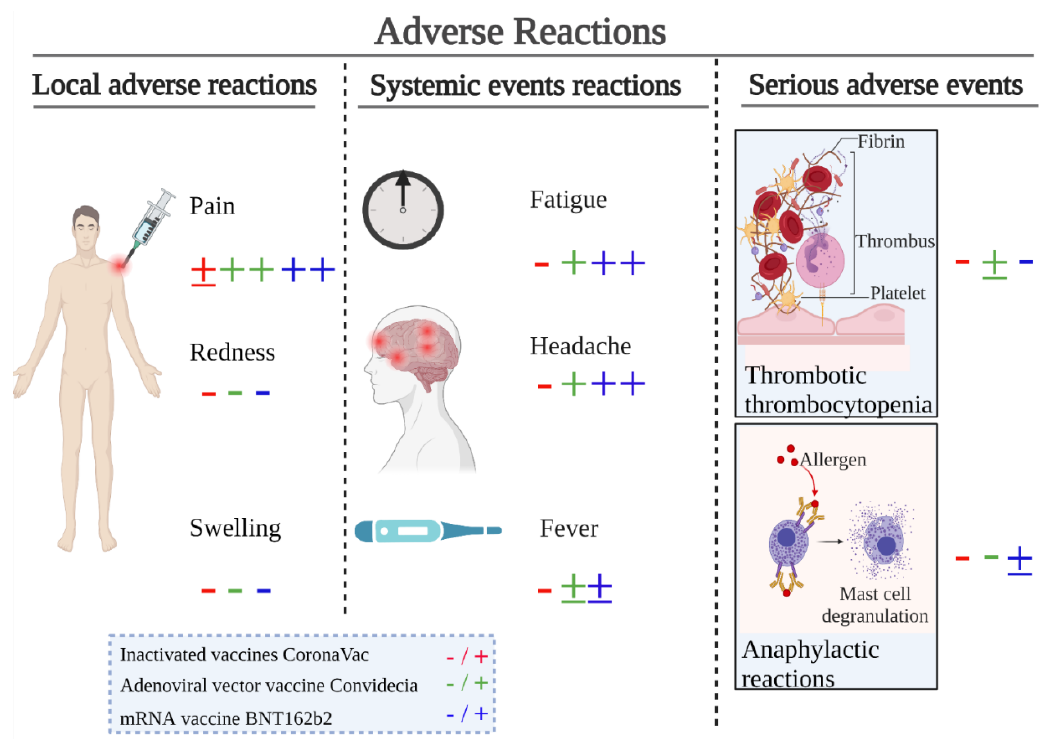
Figure 2. Illustration of common adverse reactions induced by COVID-19 vaccines. The most common local adverse reactions are pain, redness, and swelling at the injection site, whereas the common systemic adverse reactions are fatigue, headache, and fever. Serious adverse events are very rare and typically involve thrombotic thrombocytopenia and anaphylactic reactions. The incidence of each adverse reaction is denoted by different colors and symbols, with red indicating CoronaVac, green indicating Convidecia, blue indicating BNT162b2, and ‘ − ’ indicating incidence is less than 10%, ‘ ± ’ indicating incidence is 10–20%, ‘+’ indicating incidence is 20–50%, and ‘++’ indicating incidence is greater than 50%.